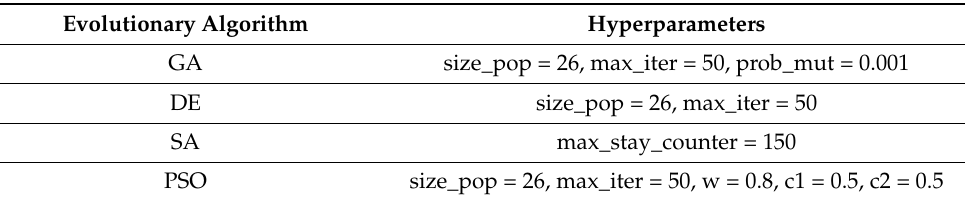
Table 6. Final hyperparameters of the four evolutionary models.